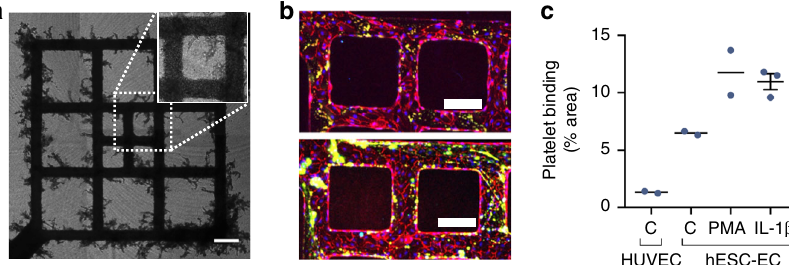
Fig. 3 Citrated whole-blood perfusion in engineered microvessels ( µ Vs). a Bright fi eld stitched large image of red blood cell- fi lled pattern and sprouts with magni fi ed view (inset, white dotted boundary) for human embryonic stem cell-derived endothelial cell (hESC-EC)-seeded µ V only constructs after 4 days of culture. Scale bar, 200 μ m. b Maximum intensity projection of confocal z -stack of constructs with adhered platelets after 30-min perfusion and subsequent phosphate-buffered saline (PBS) washes for untreated hESC-EC-seeded constructs (top) and phorbol myristate acetate (PMA)-treated hESC- EC-seeded constructs (bottom) stained for CD31 (red) and CD41a (green). Scale bar, 200 μ m. c Quanti fi cation of platelet adhesion on the vessel wall for constructs seeded with human umbilical vein endothelial cells (HUVECs) in control conditions (C – HUVEC), hESC-ECs in control conditions (C – hESC-EC), and hESC-ECs treated with PMA (PMA – hESC-EC) or interleukin (IL)-1 β (IL-1 β – hESC-EC). Data are expressed as a percentage of the vessel wall surface area. N = 2, 2, 2, and 3 biologically independent samples for C – HUVEC, C – hESC-EC, PMA, and IL-1 β , respectively. Representative images for a , b from two biologically independent samples of C – hESC-ECs and two biologically independent samples of PMA – hESC-EC, with similar results. Error bars, mean